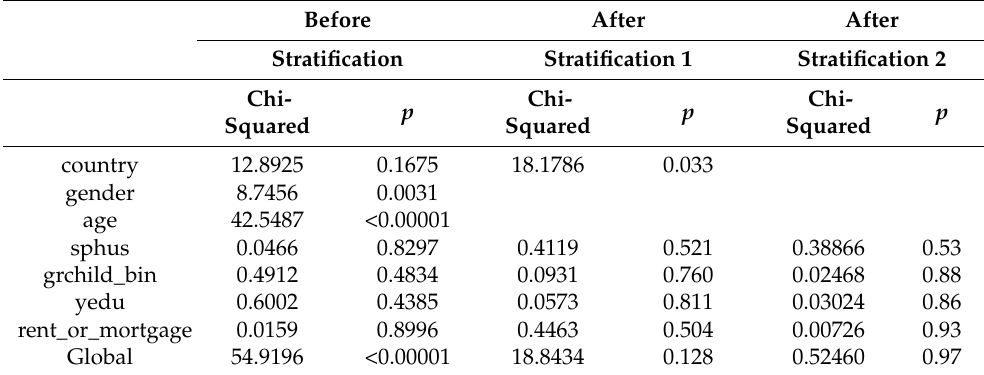
Table 4. Results of the test for the Cox proportional hazards assumption, SHARE data (N = 2882).